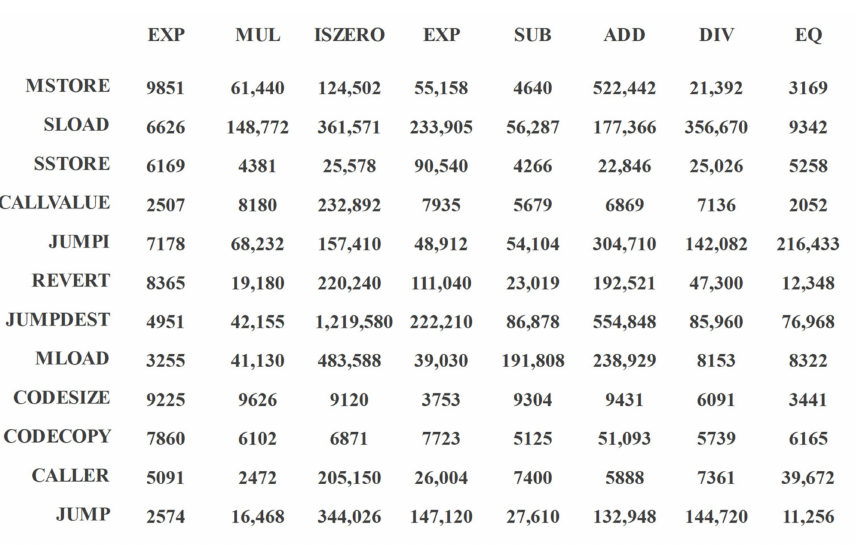
Figure 2. Co-occurrence